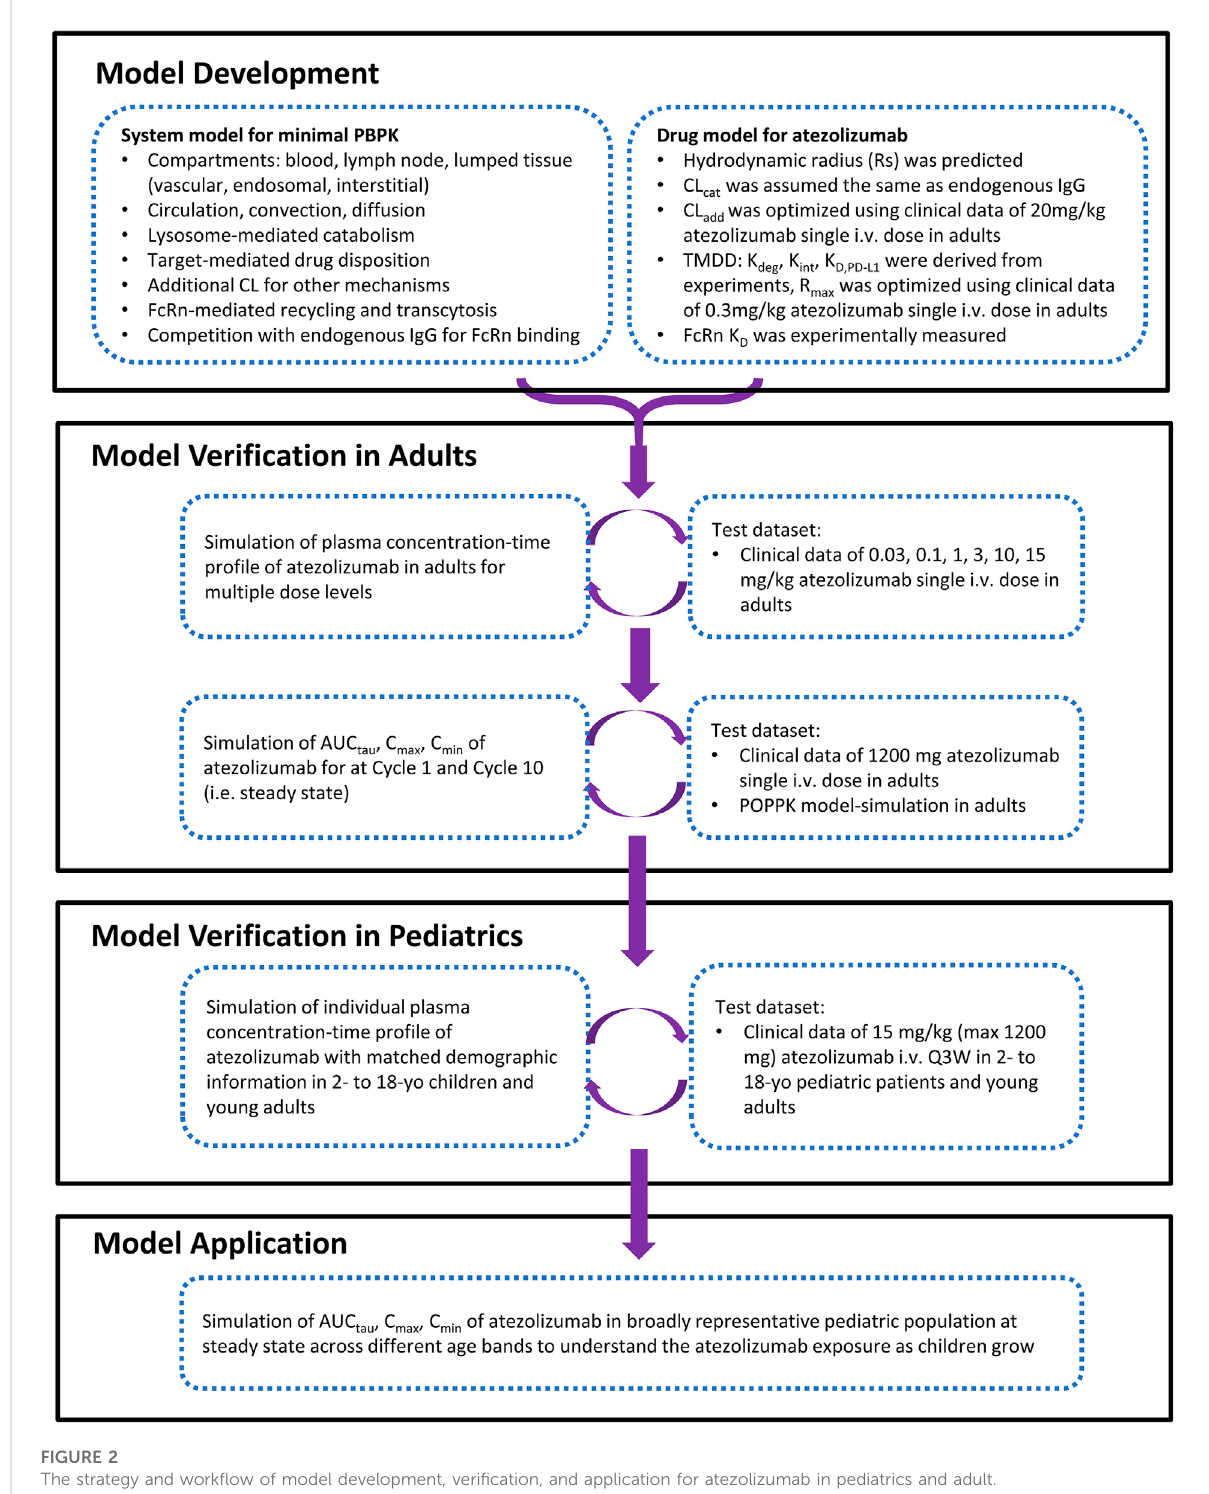
FIGURE 2 The strategy and work fl ow of model development, veri fi cation, and application for atezolizumab in pediatrics and